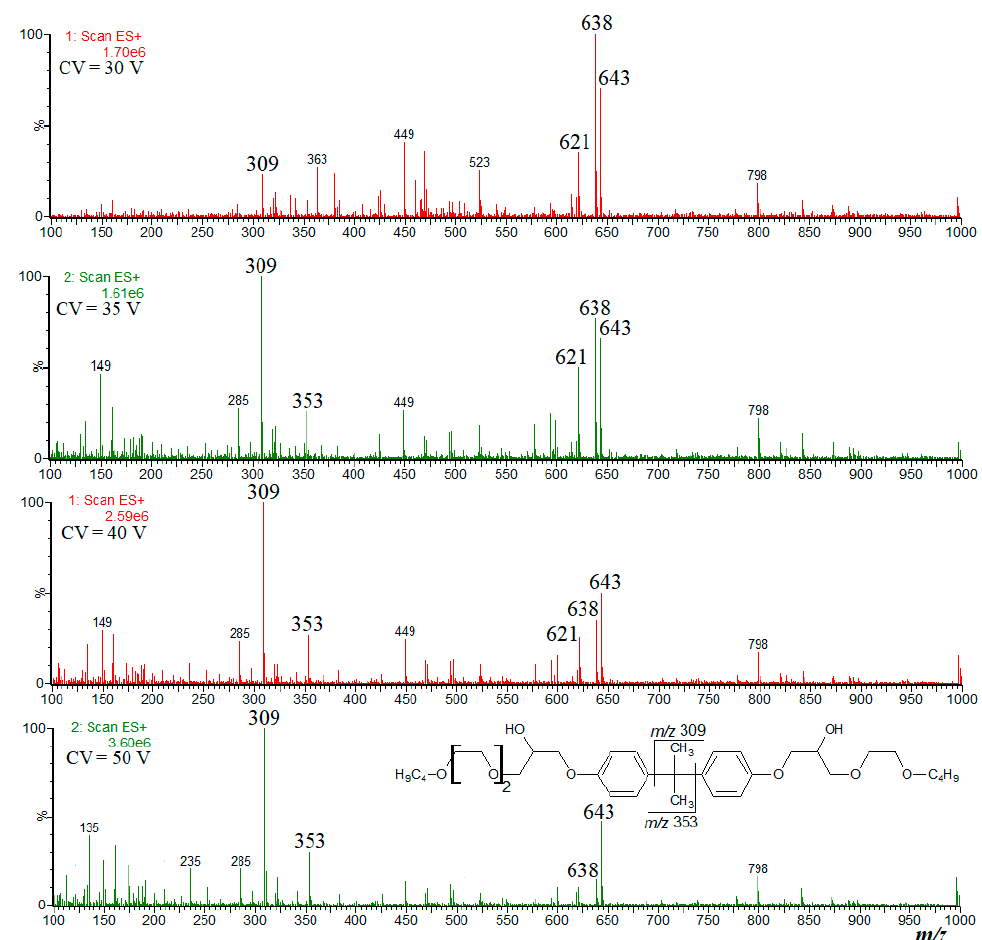
Figure 2. ESI mass spectra of BADGE + BuO(EtO) 2 H + BuOEtOH obtained during HPLC/ESI-MS analysis.